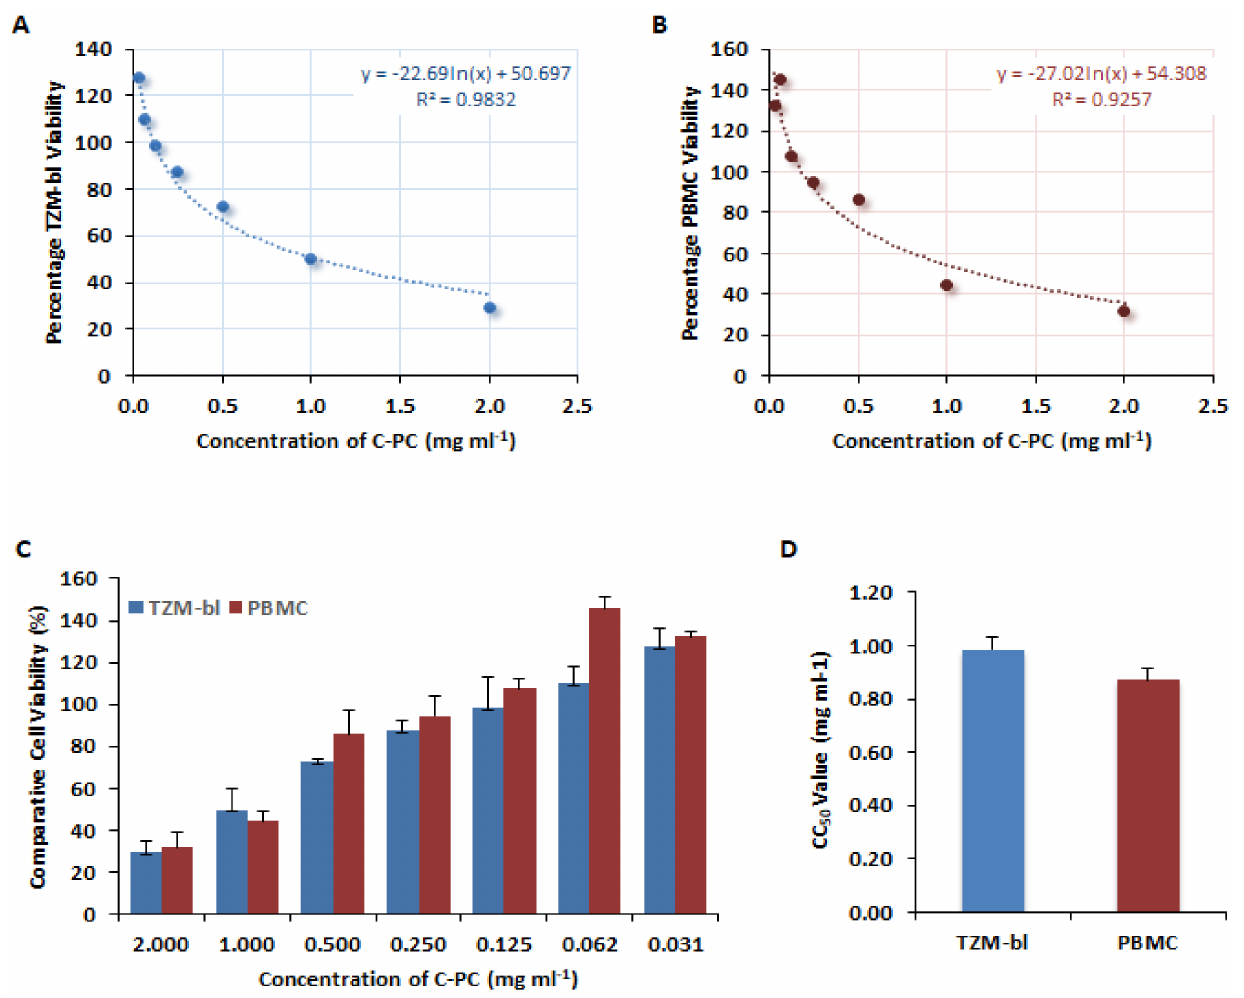
Figure 1. Determination of cytotoxic concentration of C-Phycocyanin. The effect of different concen- trations of C-PC on ( A ) TZM-bl cells and ( B ) PBMCs. ( C ) The comparative graphical illustration of viability between TZM-bl cells and PBMCs at 2.0–0.0312 mg/mL concentrations of C-PC. ( D ) The mean CC 50 values of C-PC as determined TZM-bl and PBMC from three independent assays.